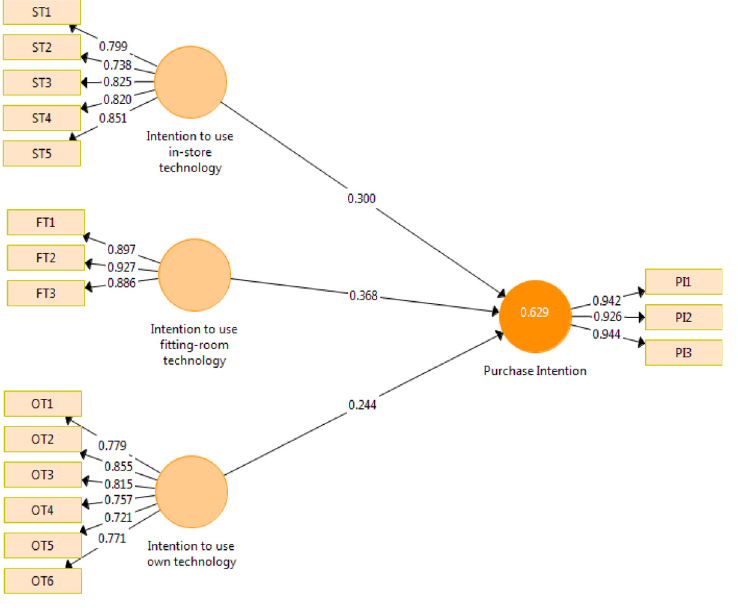
Figure 3. Measurement